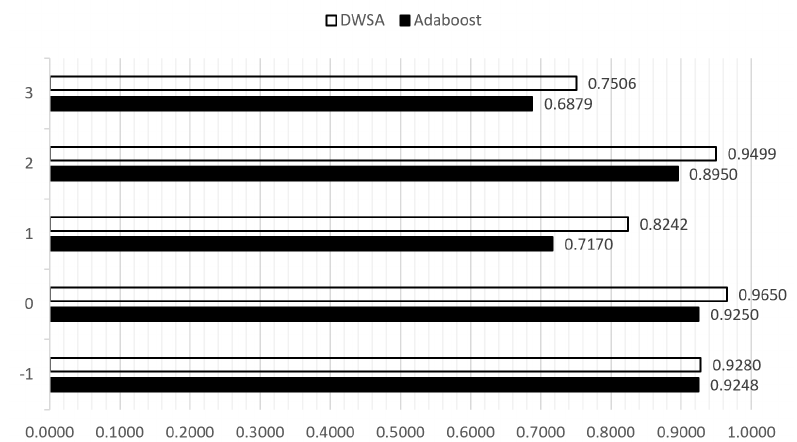
Figure 7. The comparison of the DWSA and the Adaboost algorithm (Insurance data set). The improved model increases the F1-score of the level-1 heading(1) from 71.7% to 82.42%. For the level-3 heading(3), the F1-score is increased by 6.27%. The accuracy of the level-2 heading(2) is improved by 5.49% and reaches 94.99%. The weights of useless content(-1) and body content(0) are reduced relatively, but the accuracy is still increased by 0.32% and 4%, and the final accuracy achieves 92.8% and 96.5%.